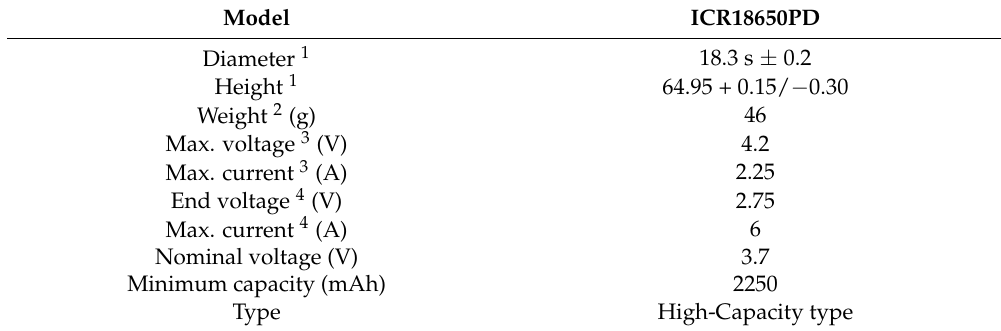
Table 1. Primary Specifications of Li-Ion cell.